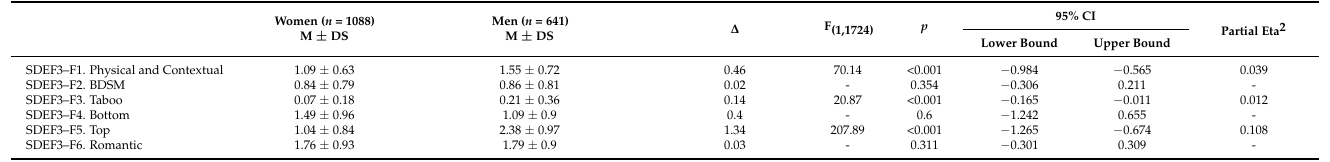
Table 5. MANCOVAs having Gender and Sexual Orientation as independent variables and SDEF3 six-factor solution as dependent ones ( n =